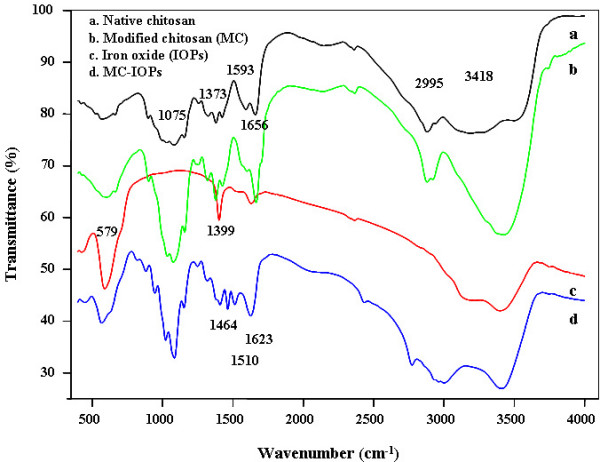
FTIR spectra of (a) pure chitosan, (b) MC, (c) pure IOPs and (d) MC-IOPs.